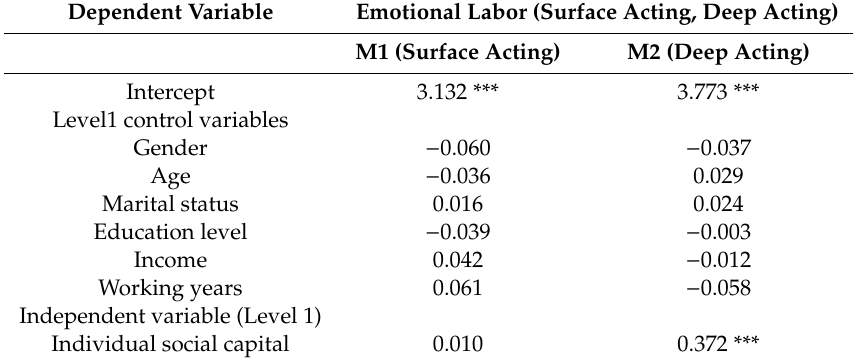
Table 7. Examining the impact of individual social capital on emotional